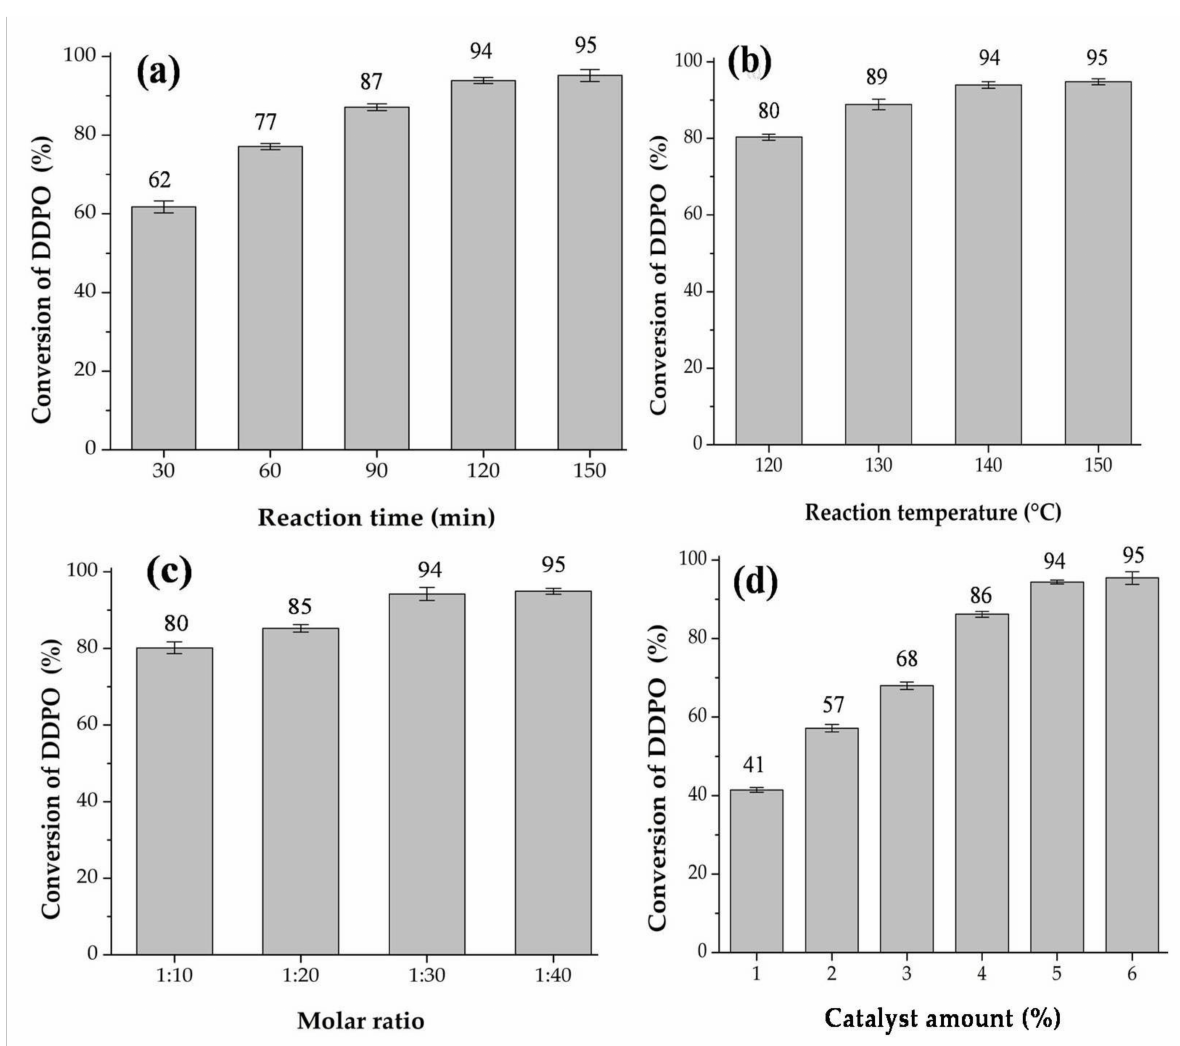
Figure 1. Influence of reaction parameters on esterification: ( a ) reaction time, ( b ) reaction temperature, ( c ) molar ratio DDPO: EtOH, ( d ) Catalyst amount. Reaction conditions: 1:30 molar ratio (DDPO: EtOH), reaction temperature 140 ◦ C, reaction time 2 h and 5%